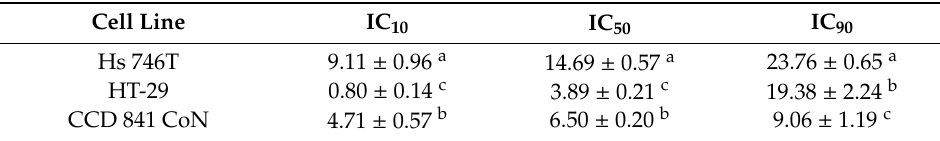
Table 6. Cytotoxic doses of PJPC [mg / mL].